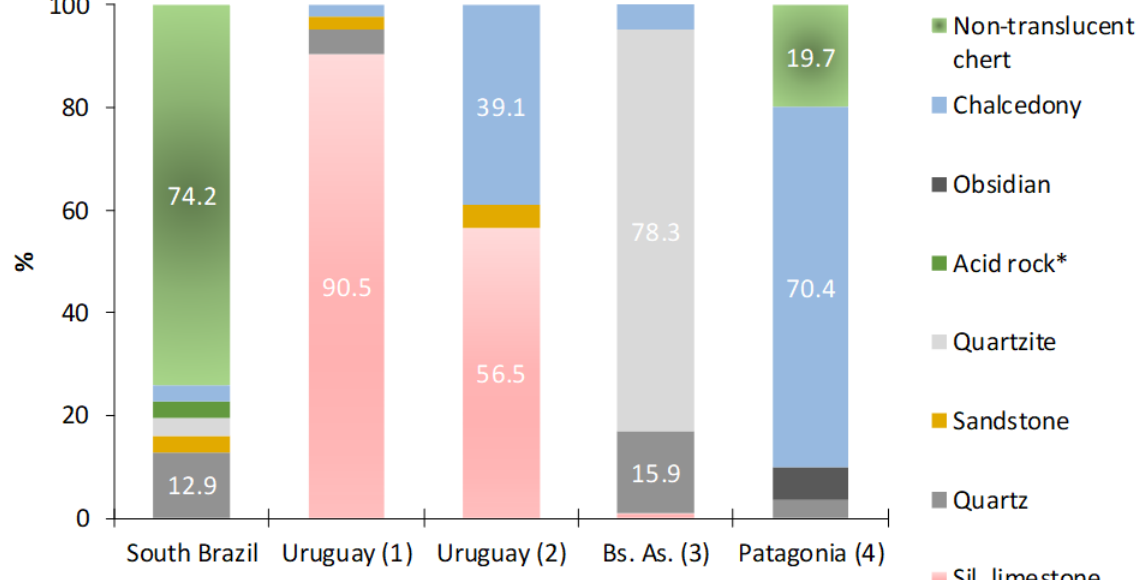
Figure 6. Raw materials in different collections of FPs. South Brazil is based on Table 1 of this study; Uruguay (1) based on Nami (2013: table 1); Uruguay (2) based on Castiñeira et al . (2011: table 1); Bs. As. (3) based on Flegenheimer & Weitzel (2017: table 3). (4) based on Somuncurá collection reported by Hermo et al . (2015: 105). The collections from Uruguay are assumed to have random selection criteria, but it cannot be